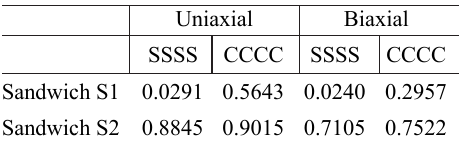
Table 5. Buckling load parameters for symmetric (S1)